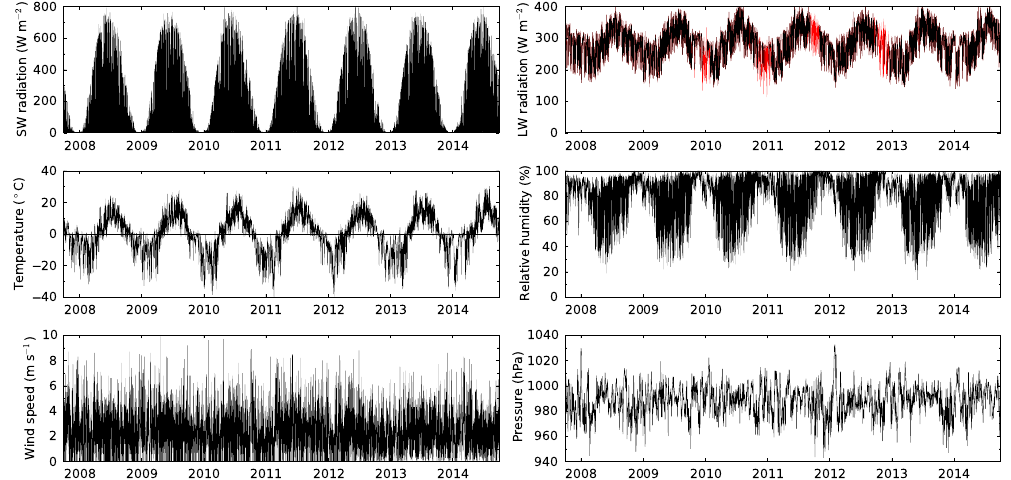
Figure 2. Hourly time series of shortwave radiation, longwave radiation, air temperature, relative humidity, wind speed and pressure. Long- wave radiation data points in red are from